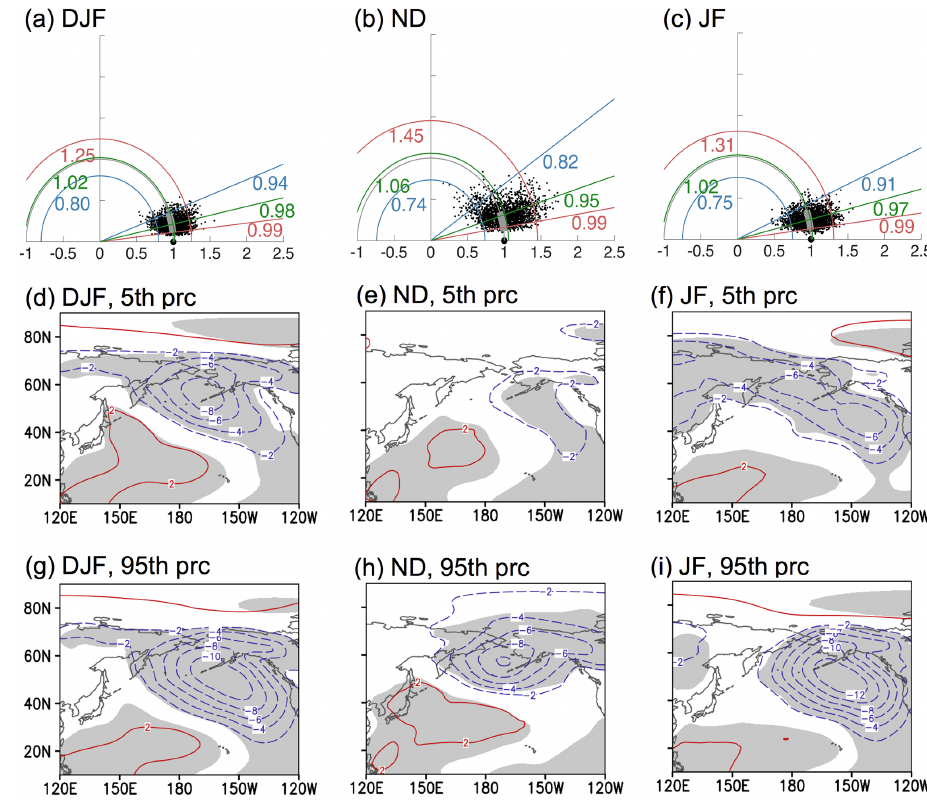
Figure 4. Same as Fig. 2 except for the North Pacific.